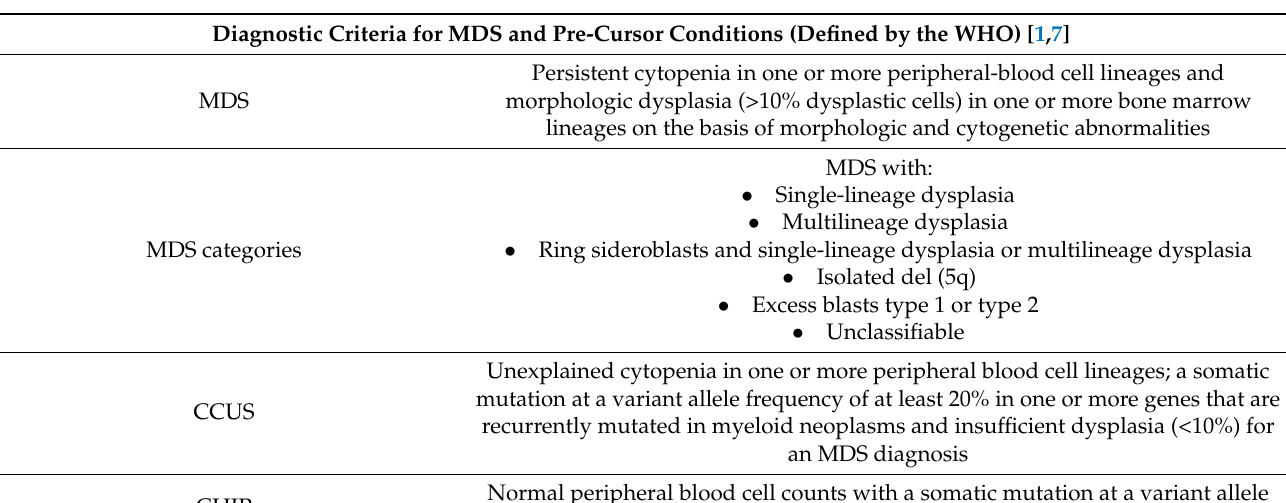
Table 1. MDS, CCUS and CHIP diagnostic